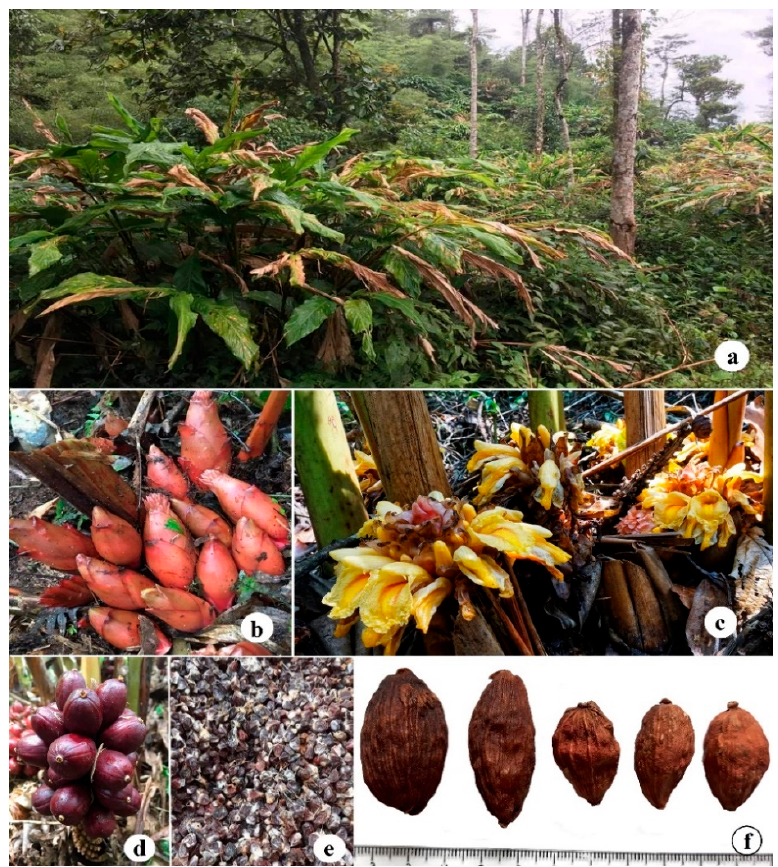
Figure 1. Black cardamom plants in Lai Chau province, Vietnam. ( a ) Black cardamom plants and their growing environment; ( b ) inflorescence shoots; ( c ) bloomed inflorescences; ( d ) fresh capsules; ( e ) fresh seeds; ( f ) dried ripe capsules (Photo by Ma A Chang, 2020). A voucher specimen (No. QF 001) was deposited at the herbarium of Hanoi Pedagogi- cal University N ◦ 2, Vietnam. Botanical identification was achieved by Dr. Tam H.